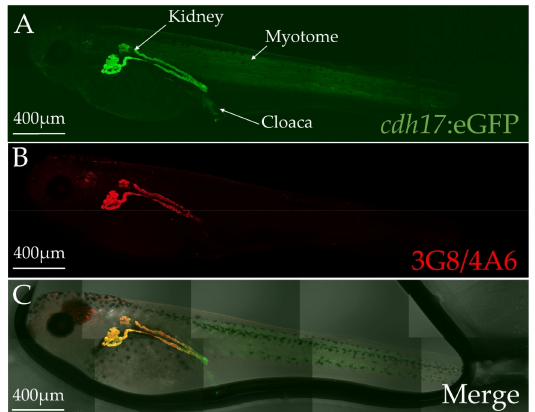
Figure 2. cdh17 :eGFP expression co-localizes with the kidney markers 3G8 and 4A6. Stage 42 cdh17 :eGFP transgenic X. laevis embryos were co-immunostained with antibodies for green fluorescent protein (GFP) and the kidney markers 3G8 and 4A6. ( A ) GFP immunostained cdh17 :eGFP embryo. ( B ) 3G8/4A6 immunostained embryo. ( C ) Merged differential interference contrast (DIC) and fluorescent image of cdh17 :eGFP embryo. Embryo is surrounded in a bubble of 1:2 volume benzyl alcohol to benzyl benzoate (BABB).